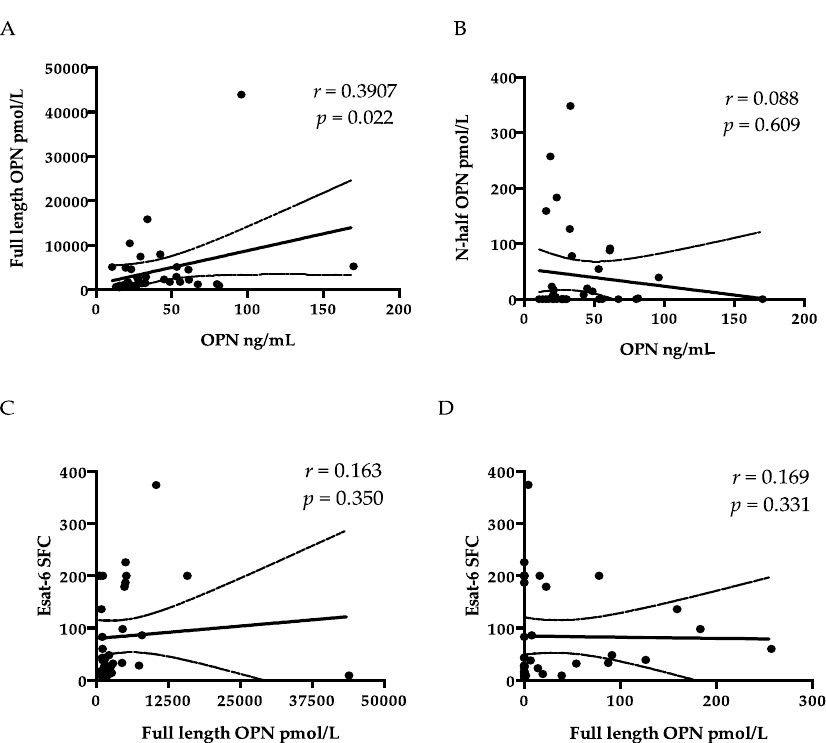
Figure 3. OPN, full-length OPN, n-half OPN, and ESAT-6 SFC count in TB patients. A comparison of plasma levels of OPN with full-length OPN ( A ) and with n-half OPN ( B ); and a comparison of ESAT-6 ELISPOT SFC counts with full-length OPN ( C ) and with n-half OPN ( D ).